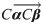
Comparison of the angle between the CαCβ→ directions in original Anton data and reconstructed data using the present Statistical Method (Stat), ScwrIPP and Remo.a) for the villin data and b) for the ww-domain data.